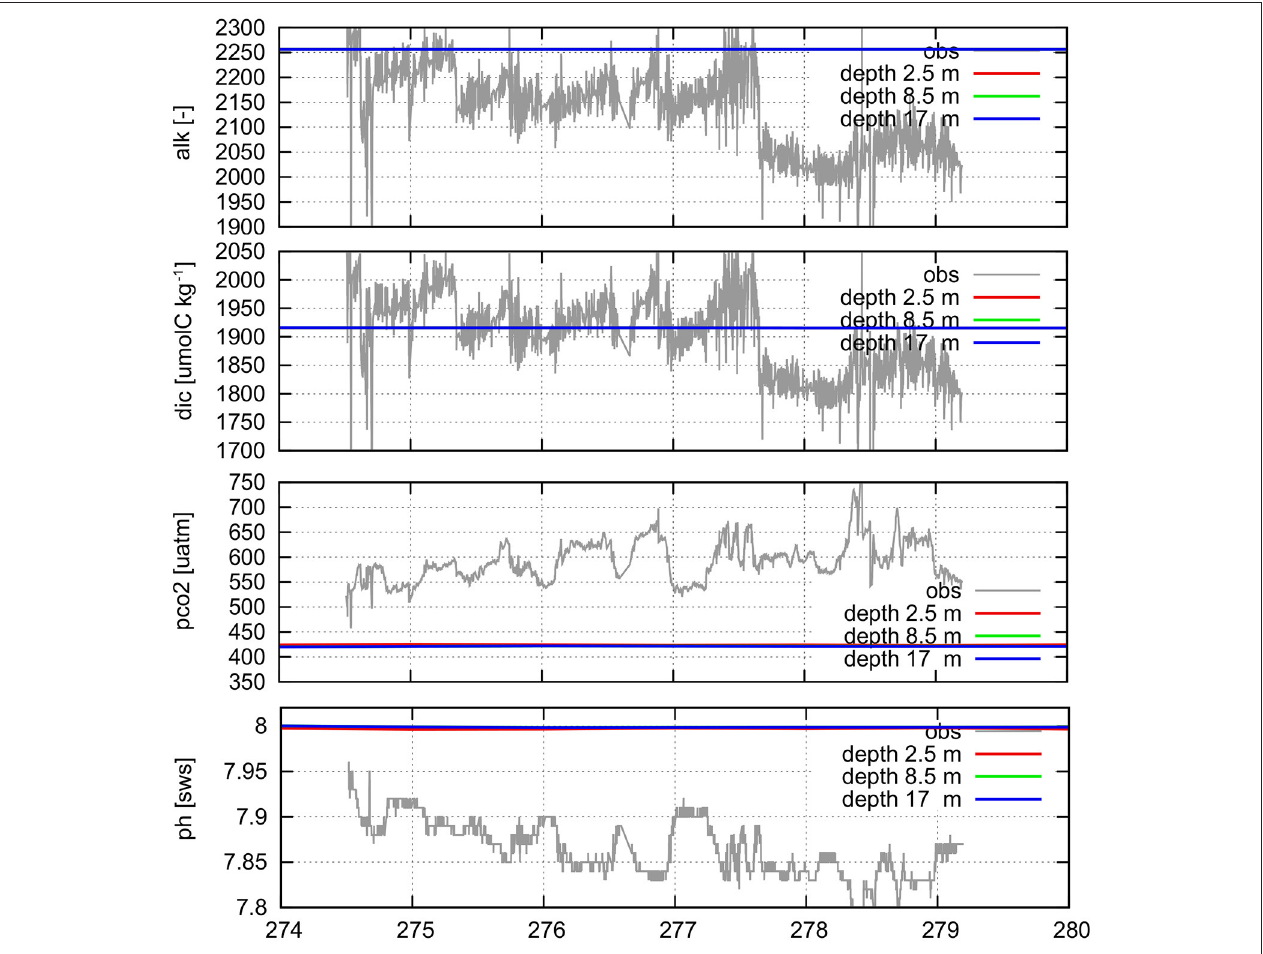
FIGURE 5 | Simulated and measured TA (alk), DIC, partial CO 2 pressure (pco2), and pH in the surface water at Banten Bay, just north of western tip of Java. For the measured data, TA and DIC were calculated from the other two parameters. Labels along the x axis are Julian days of 2012 (274: 30